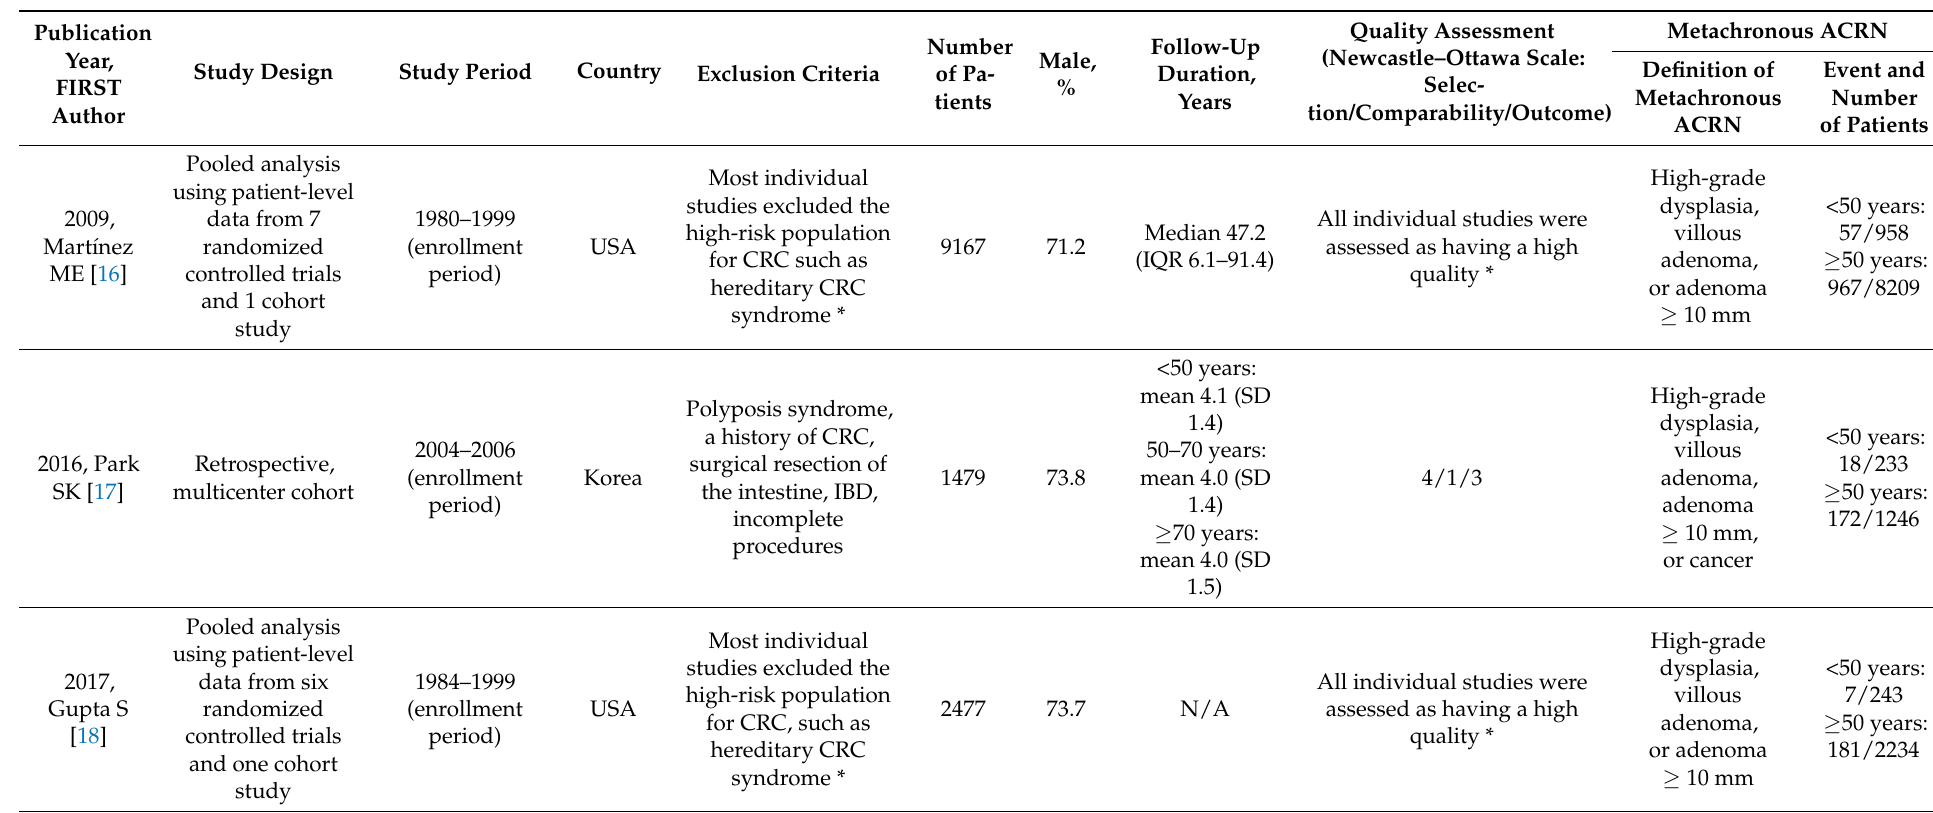
Table 1. Baseline characteristics of the included studies and risk of metachronous lesions according to age